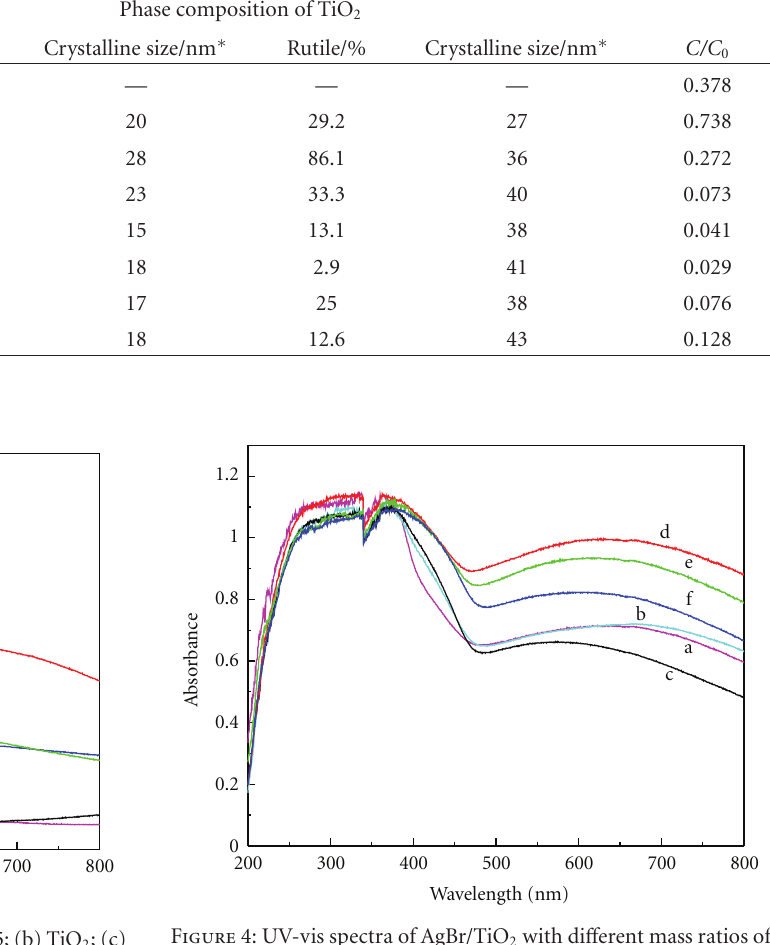
Figure 3: UV-Vis spectra of di ff erent samples. (a) P25; (b) TiO 2 ; (c) AgBr; (d) AgBr/P25; (e) AgBr/TiO 2 .